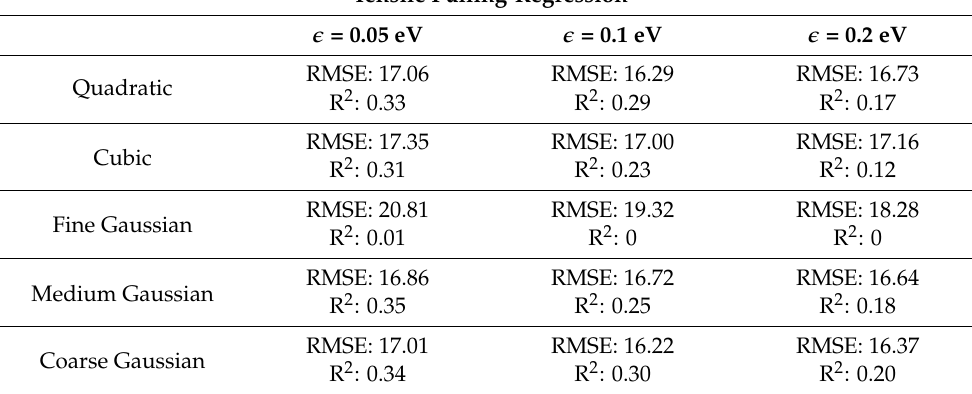
Table 1. Prediction performance of the SVM with various kernels on rough surfaces with different epsilon values. The RMSE values have units of MPa. The smaller RMSE, the higher the prediction accuracy. The R 2 values are dimensionless. The higher the R 2 , the better the prediction. Table 1. Cont.